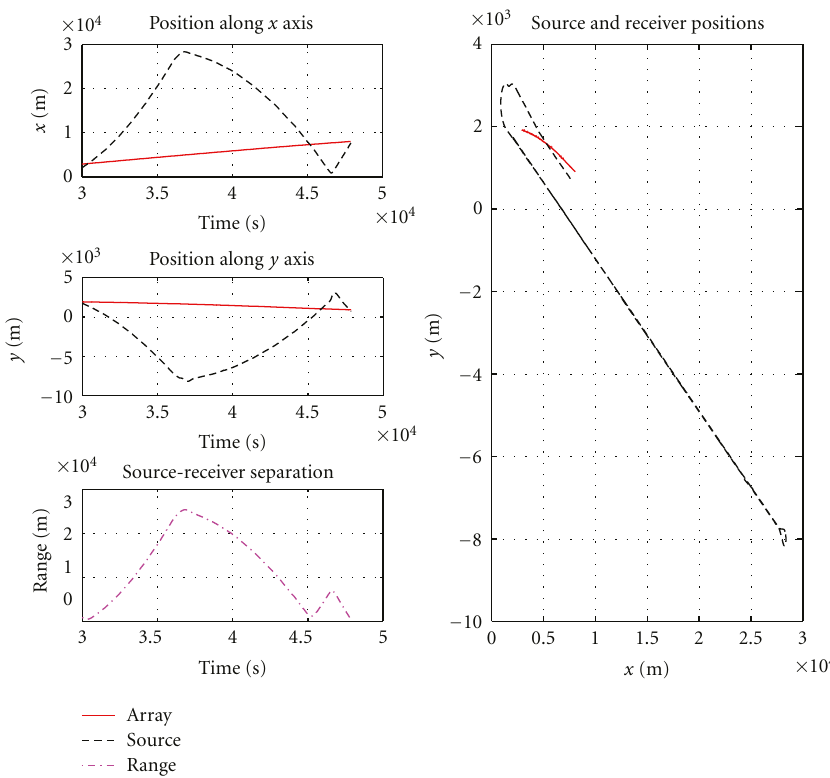
Figure 14: Positions of the towed source and of the hydrophones along time and evolution of the source-receiver separation along time for the BASE07 experiment.